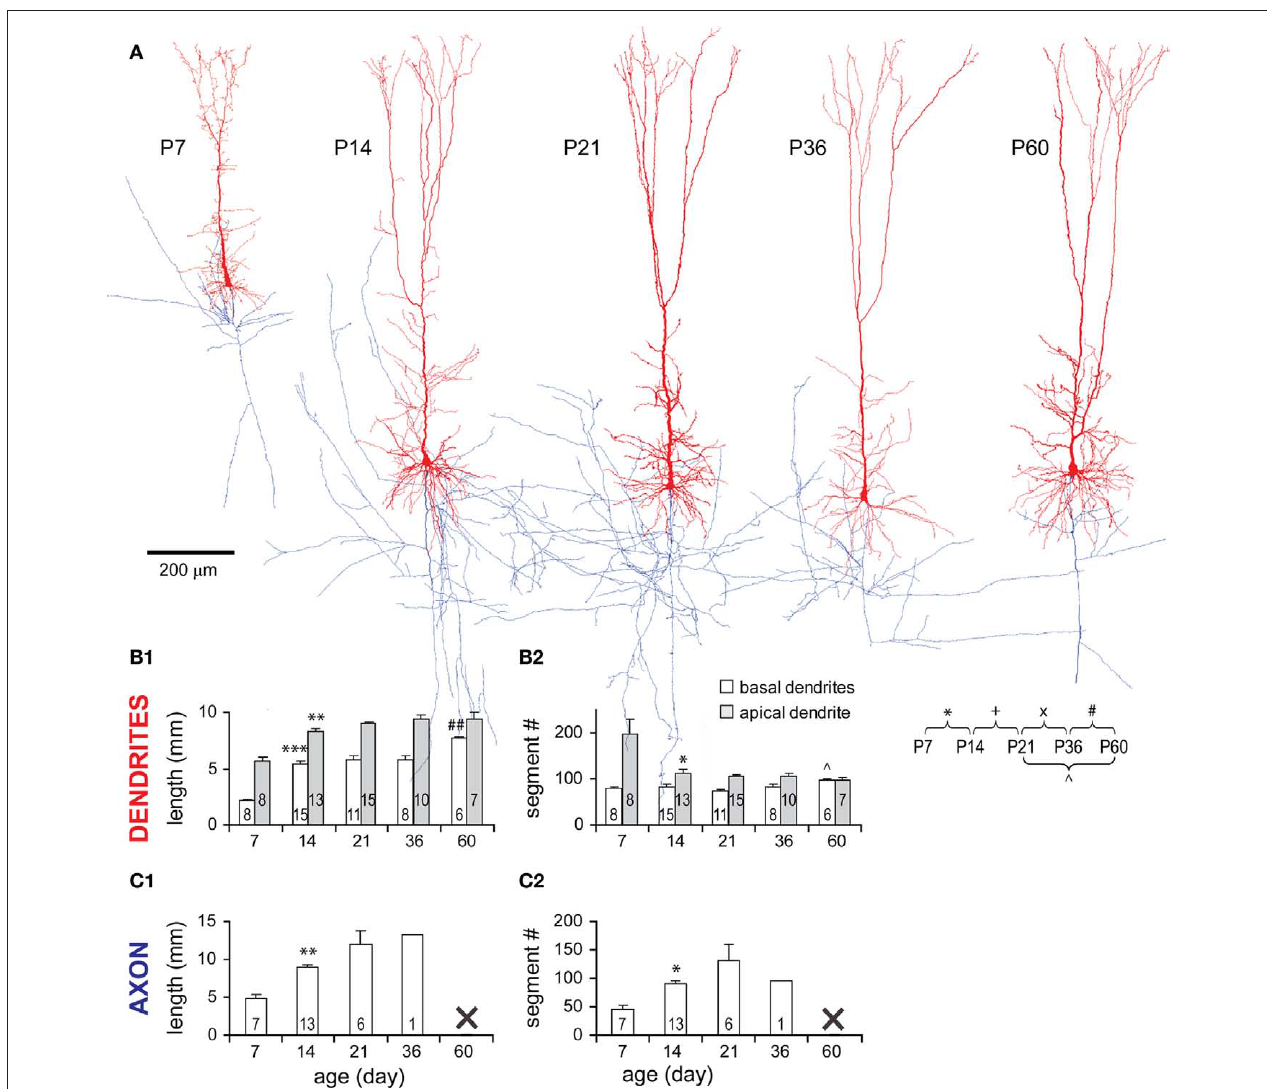
there was a significant increase in the total number of basal dendritic segments. (C1) Total axonal length significantly increased from P7 to P14. (C2) Total number of axonal segments significantly increased from P7 to P14. Note that the data for the axons of neurons at P36 and P60 are insufficient for the analyses of total length and segment number. This is because axonal collaterals in slices from P36 and P60 rats were often invisible at deep focusing levels under